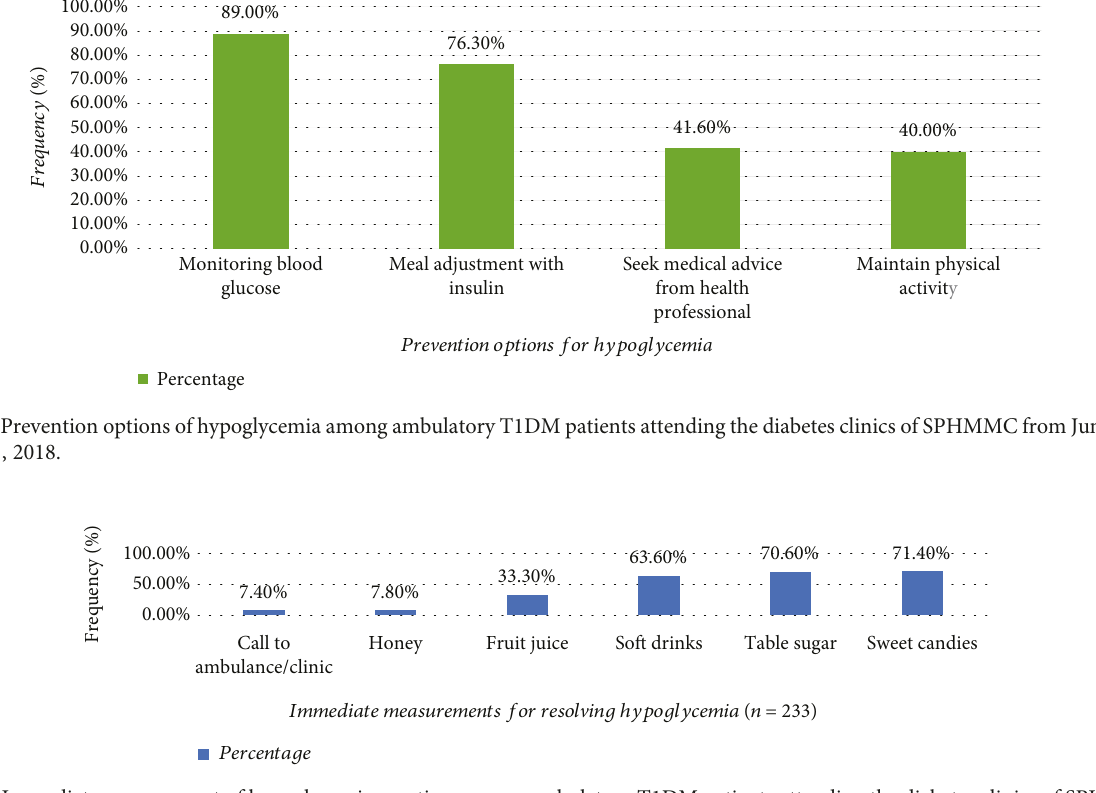
Figure 4: Immediate management of hypoglycemia practices among ambulatory T1DM patients attending the diabetes clinics of SPHMMC from June 01 to August 01, 2018. Table 4: Multivariate logistic regression analysis results of factors associated with hypoglycemia events among ambulatory T1DM patients attending the diabetes clinics of SPHMMC from June 01 to August 01,